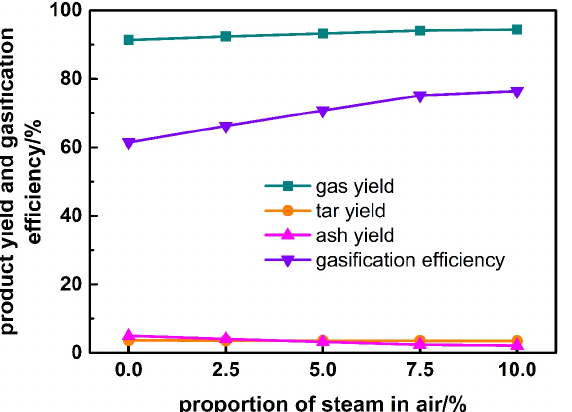
Figure 10. Effect of steam proportion in air on product yield and gasification efficiency.